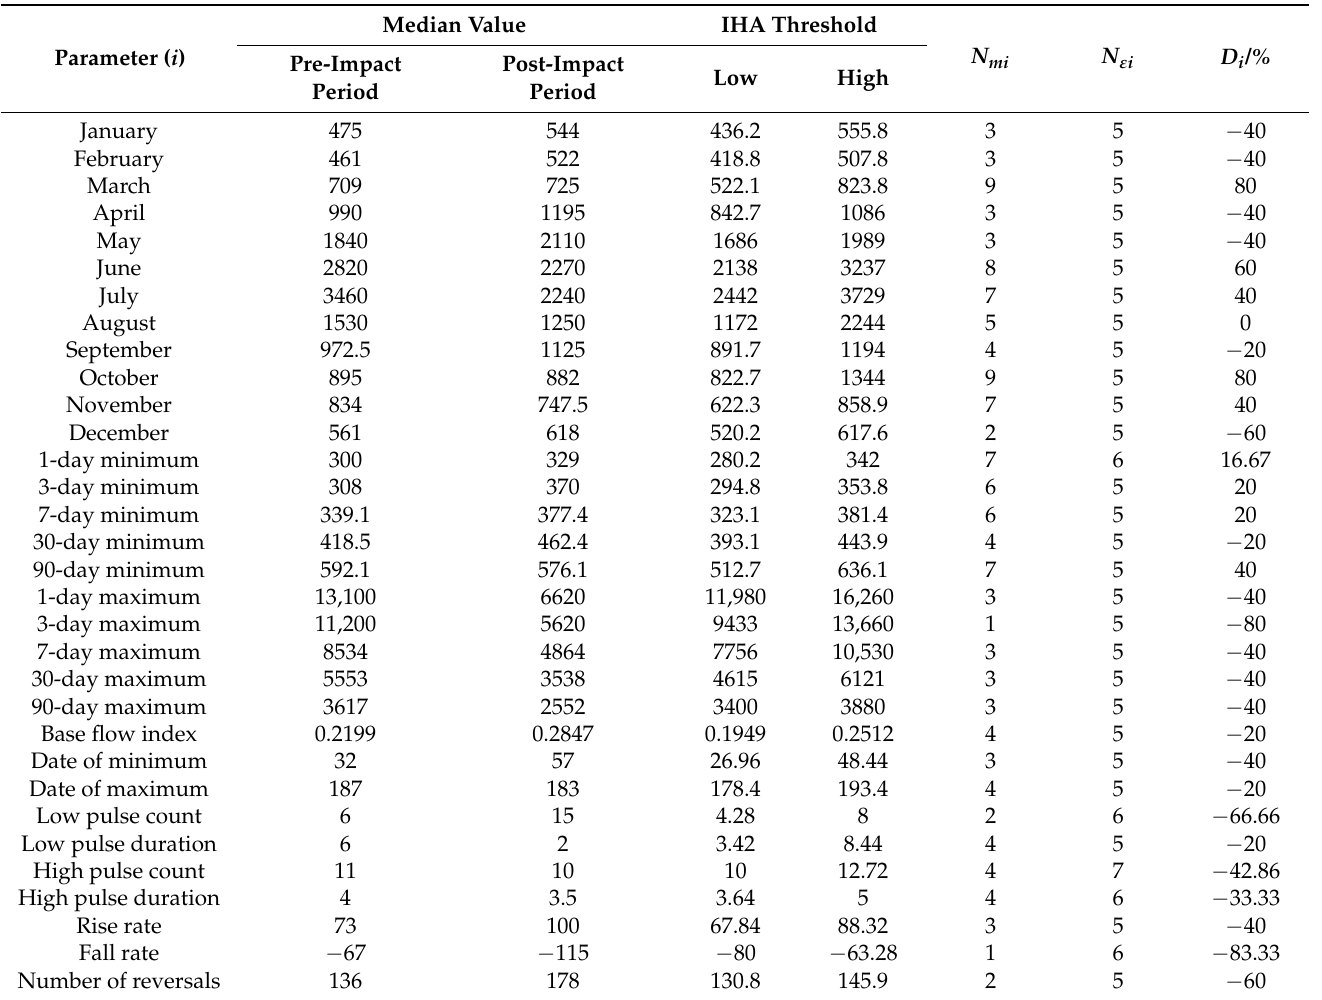
Table 3. Results of IHA change degree under different periods at Wulong